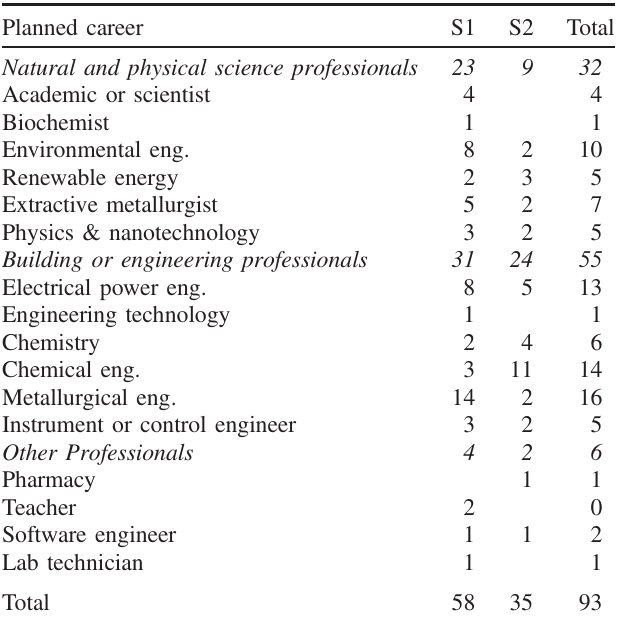
TABLE I. Planned future careers of participants. Note that S ¼ semester, Eng ¼ engineer. Planned careers were grouped using the Australian Classification of Occupations , (Australian Bureau of Statistics,